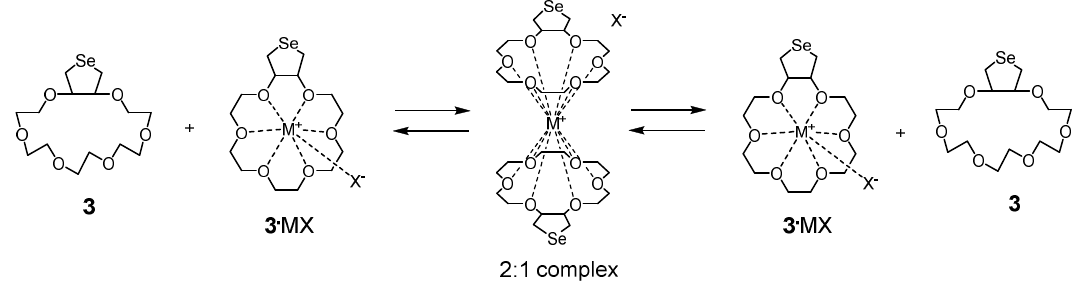
Figure 5. A plausible mechanism for an alkali metal ion exchange between two molecules of 3 .